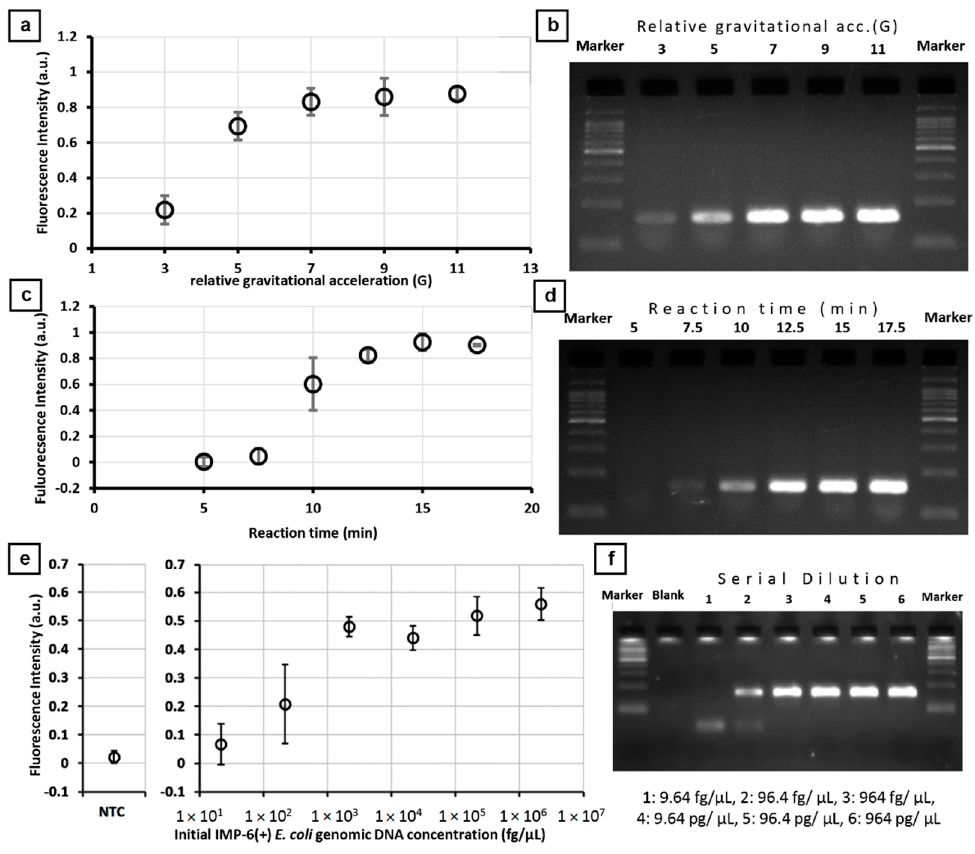
Figure 4. On-chip PCR to detect bla IMP-6 from the laboratory isolate 10,806 and verified with gel electrophoresis. ( a ) Fluorescence signal detected at various relative acceleration when operated at 10 min. ( b ) Corresponding gel electrophoresis analysis. ( c ) Fluorescence signal detected at various reaction times at 7G. ( d ) Corresponding gel electrophoresis analysis. ( e ) Fluorescence signals of the prepared dilution series (9.64 fg/µL to 964 pg/µL). ( f ) Corresponding gel electrophoresis analysis. All measurements were done in triplicates. Error bar represents standard deviation.